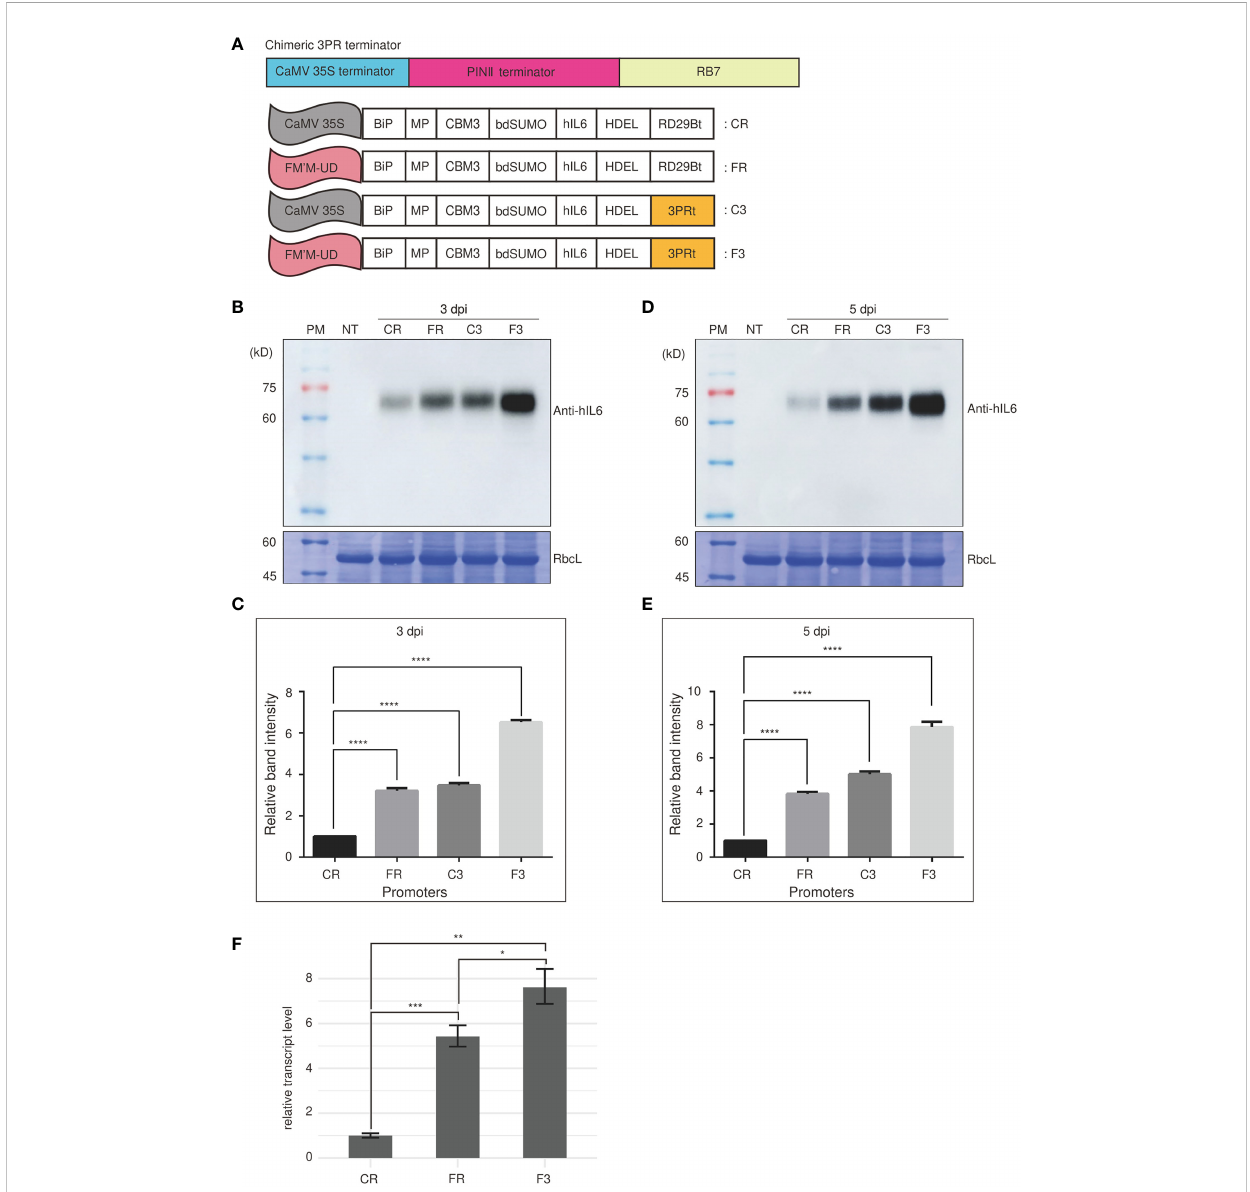
FIGURE 5 An arti fi cial hybrid terminator, 3PRt, strongly enhances expression driven by the FM ′ M promoter. (A) Schematic presentation of the 3PR terminator and reporter constructs. (A) DNA fragments from the CaMV 35S terminator, the PINII terminator, and RB7 were fused to produce the 3PR terminator (3PRt). (A) The different expression constructs used in this study. CR: CaMV 35S promoter plus RD29Bt; FR: FM ′ M-UD promoter plus RD29Bt; C3: CaMV 35S promoter plus 3PRt; and F3: FM ′ M-UD promoter plus 3PR terminator. (B-E) Analysis of the expression level of reporter proteins. Leaf tissues of N. benthamiana were in fi ltrated with the indicated constructs. Total soluble proteins were prepared from leaf tissues harvested at 3 (B, C) and 5 dpi ( D, E ), and analyzed by western blotting using anti-hIL6 antibody. Identical membranes were stained with CBB to visualize RbcL, used as a loading control ( B, D ). To quantify the expression levels at 3 and 5 dpi, the band intensities of immunoblot images in (B, D) were measured using the LAS-3000 imaging system; values shown are relative to that produced by the CaMV 35S promoter. The data shown are means ± SE (n = 3); asterisks indicate statistically signi fi cant differences determined using one-way ANOVA followed by Dunnett ’ s multiple comparison test; ****: P < 0.0001. (F) Comparison of the hIL6 transcript levels produced by the CR, FR and F3. A hygromycine resistant gene in the same vector was used as an internal control. The data shown are means ± SD (n = 3). Asterisks indicate statistically signi fi cant difference determined by two-tailed Student ’ s t -tests; *: P < 0.05; **: P < 0.01; ***: P <